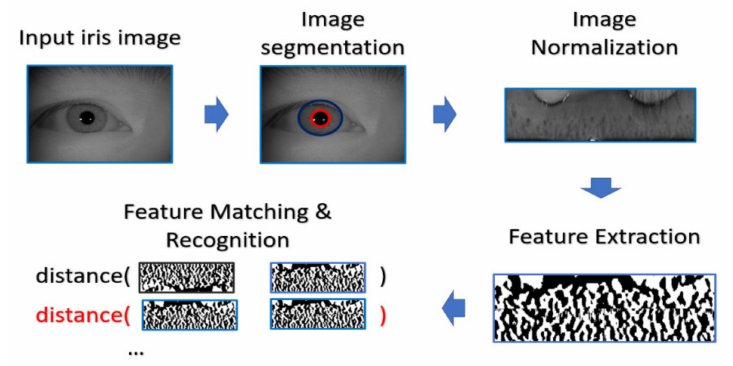
Figure 10. The classical procedure for iris recognition.